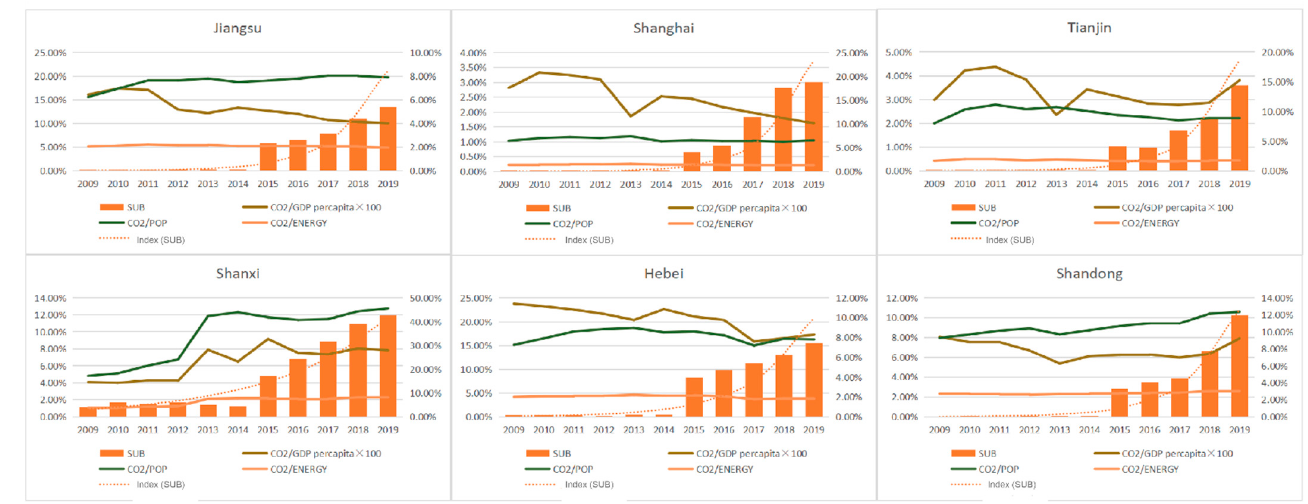
Figure 7. The Carbon Emission and SUB change across 30 provinces in China (2009–2019).